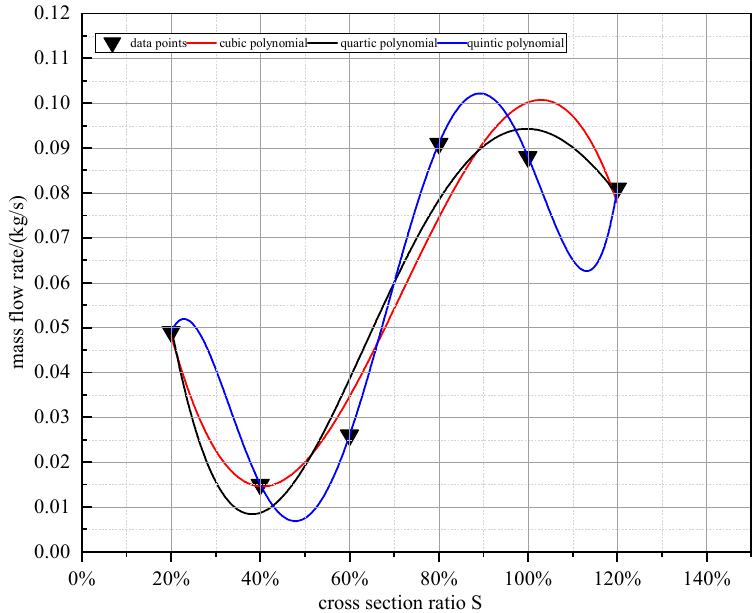
Figure 10. The fitting curve of the S-values and air mass flow rates.